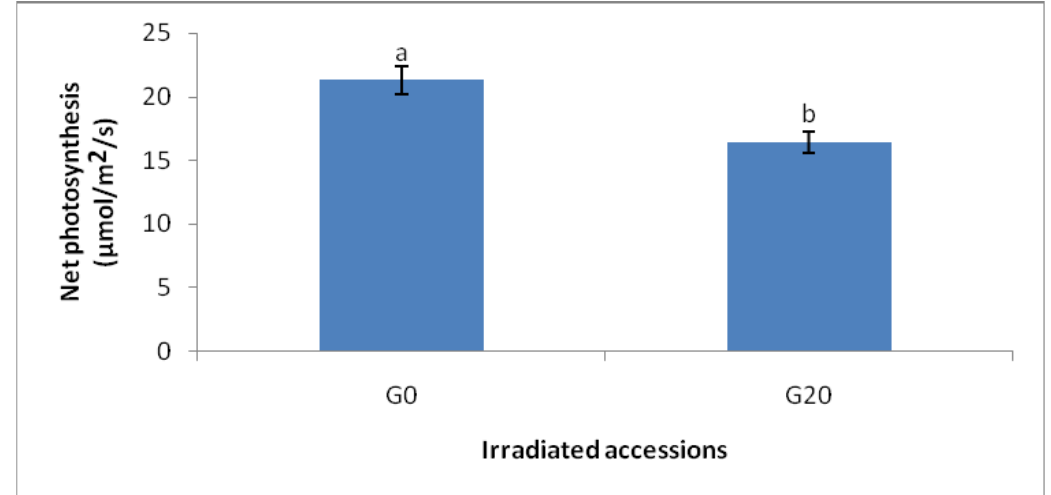
Figure 3. Effects of different gamma irradiation dosage on net photosynthesis of plants of C.asiatica; n = 4 (G0 = Control; G20 = Plants irradiated to 20 Gy).